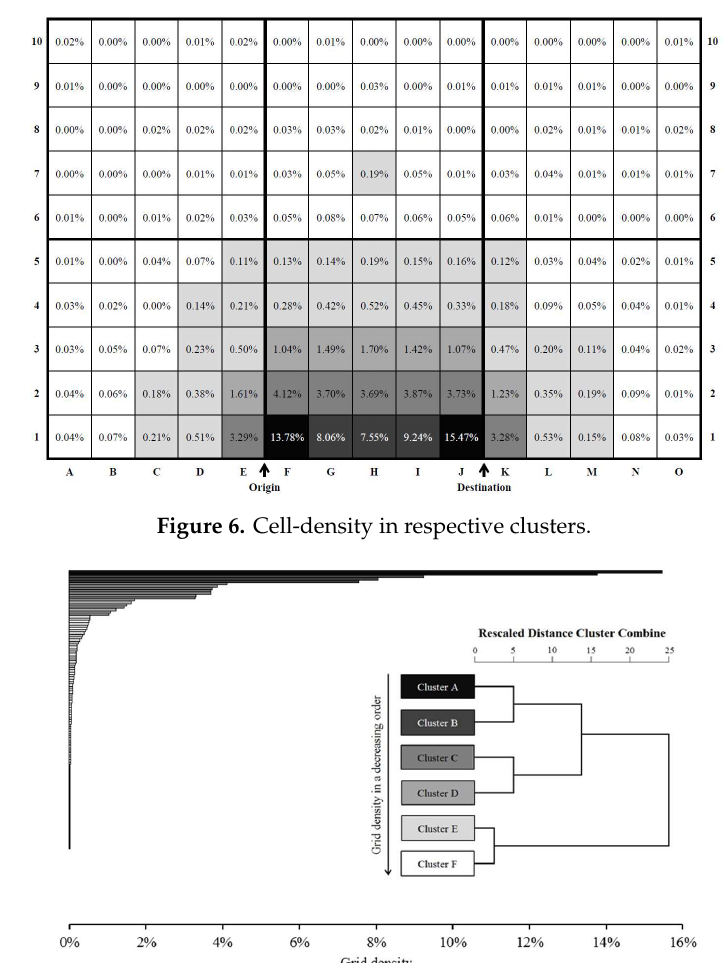
Figure 7. Cell density dendrogram.